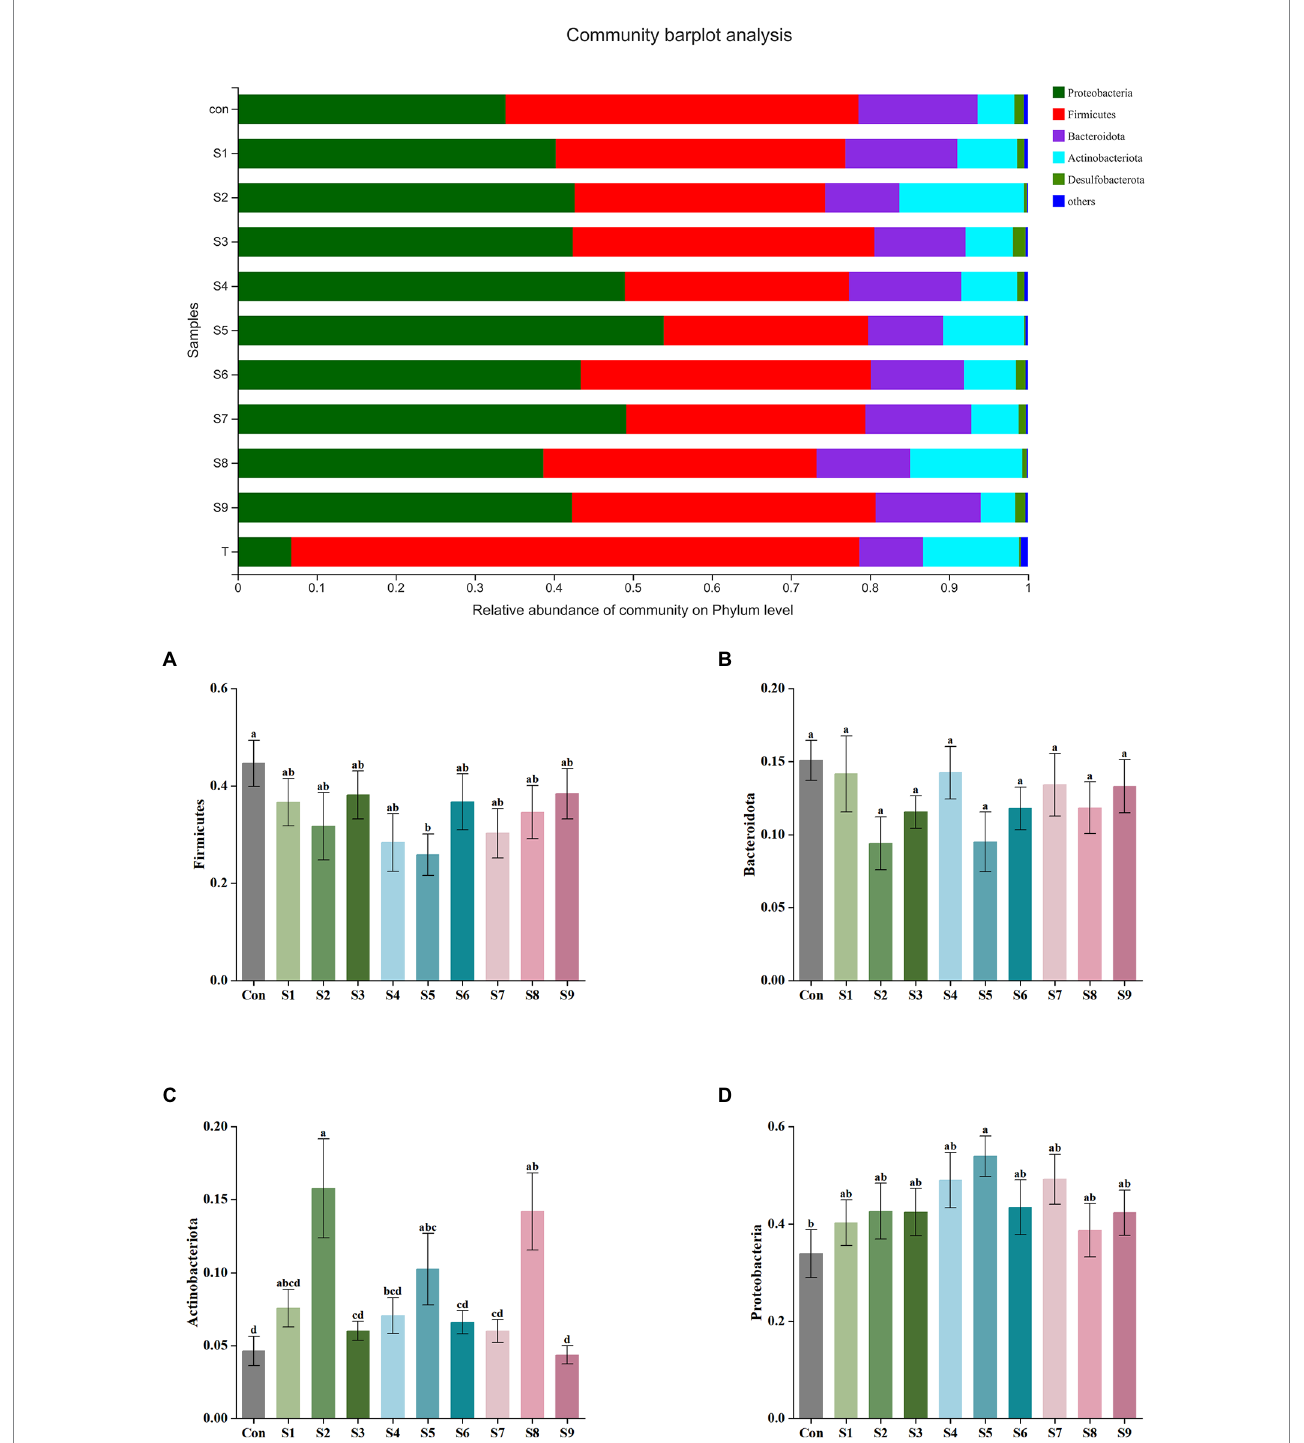
FIGURE 3 Composition of original fecal microbiota (T) and the abundance of fecal microbiota at the phylum level. Relative abundance of Firmicutes (A) , Bacteroidota (B) , Actinobacteriota (C) , and Proteobacteria (D) in fecal microbiota after fermentation. Data are means ± SEM (10 independent experiments). Different lowercase letters indicate significant differences ( p <